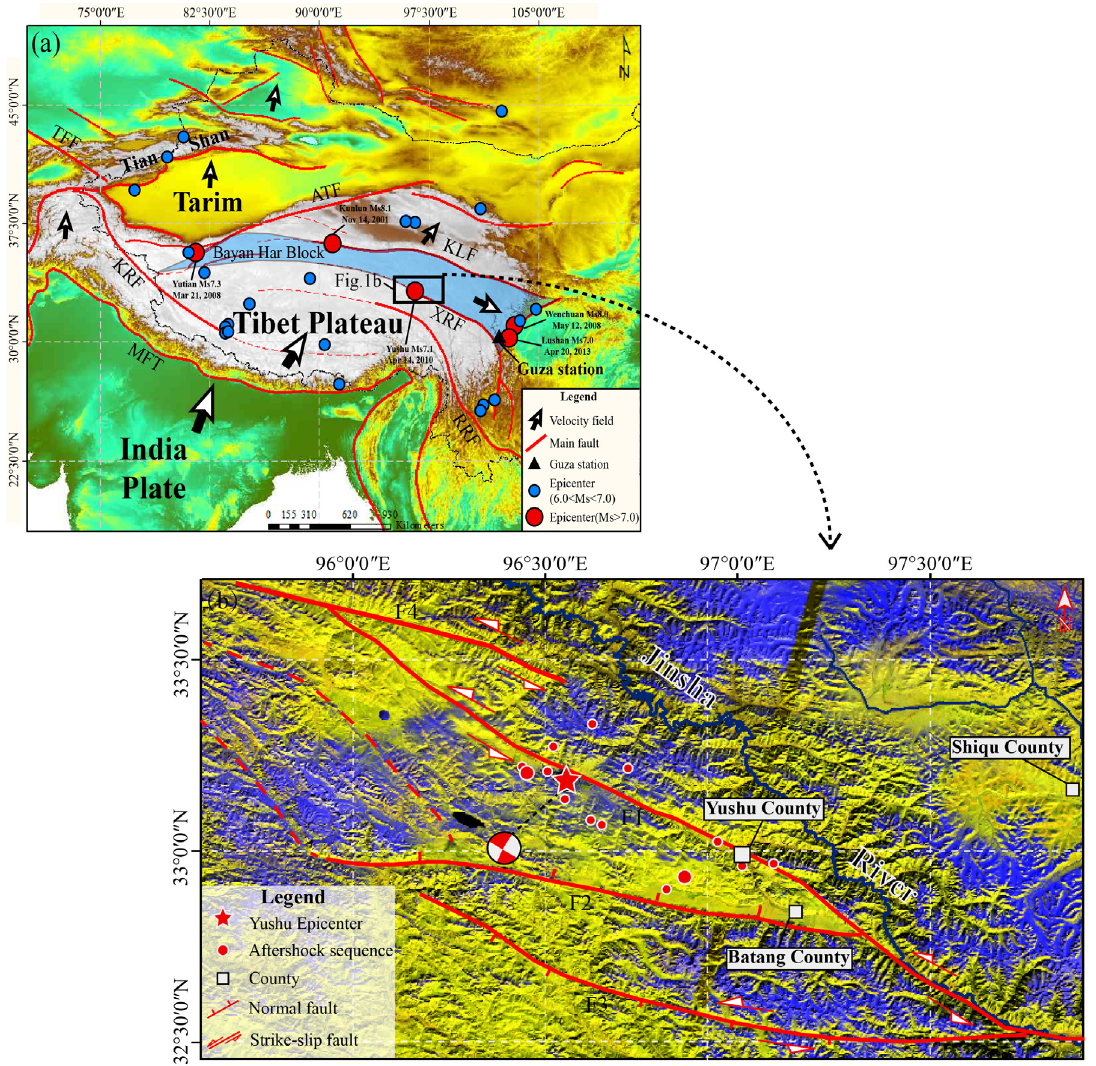
Figure 1. Simplified active tectonic map of the Tibetan Plateau and surrounding region (a) and the Ganzi-Yushu region overlapped on a false color image from Landsat ETM+ (b). Major fault systems are: ATF-Altyn Tagh fault, KLF-Kunlun fault, KRF-Karakoram fault, MFT-Main frontal fault, RRF-Red River fault, XRF-Xianshuihe